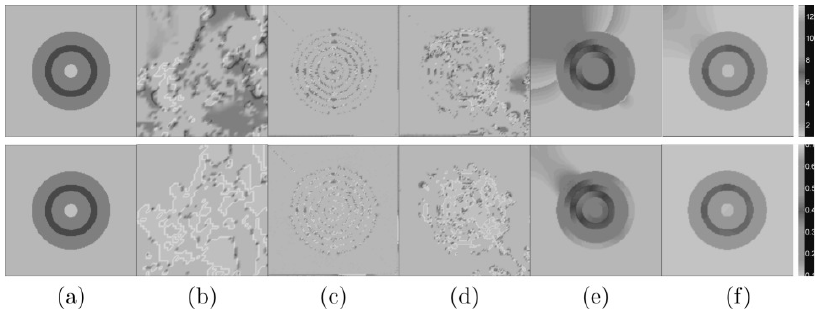
Figure 6. Case 3: Simulation results for µ (first row) and η µ (second row) image reconstruction. (a) True images; (c) direct inversion method; (e) hybrid one-step method; (b), (d) and (f) are reconstructed images by the adjoint-based optimization method (2.13) with initial guess of the constant µ 0 + iωη µ , (c) and (e), 0